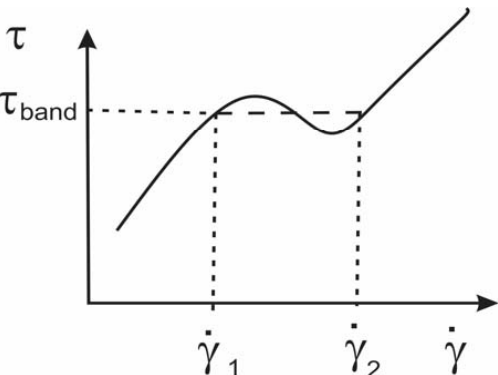
. γ < . γ . γ > . γ 1 and 2 . In the = τ band .